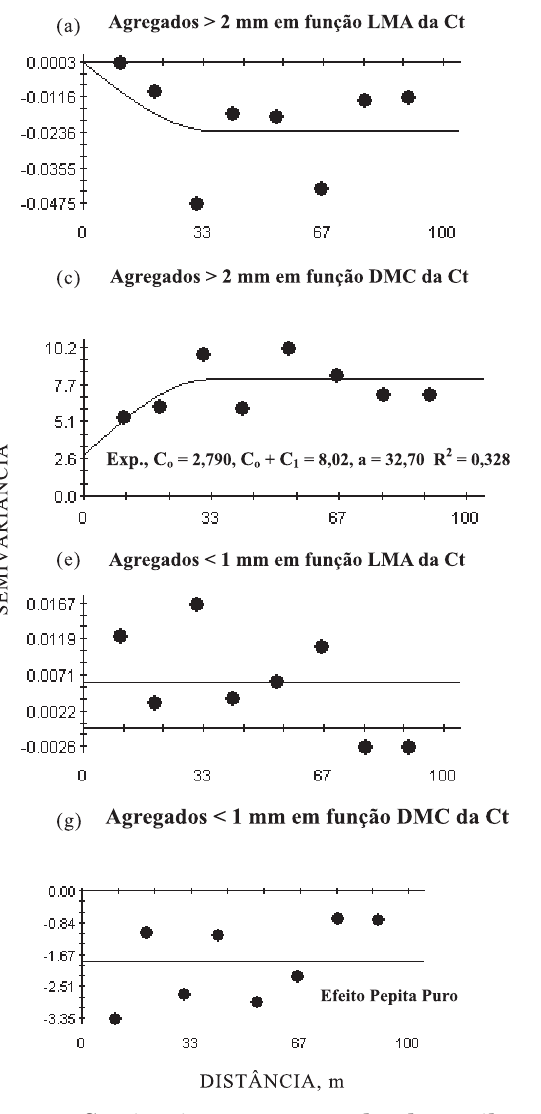
: efeito pepita; C : patamar; o 1